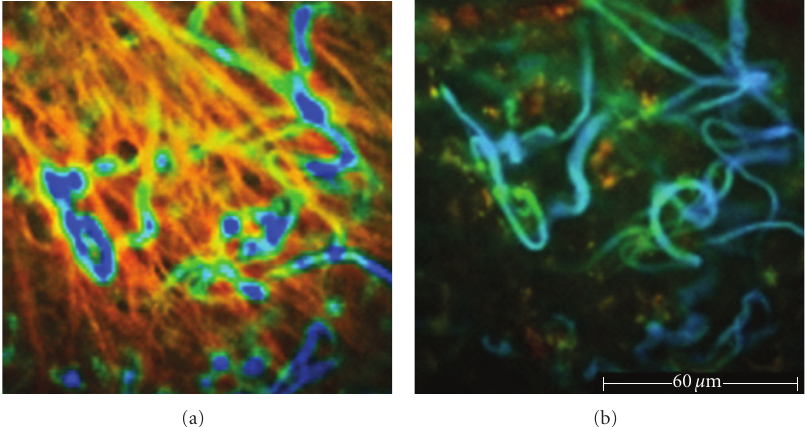
Figure 8: Dermis. (a) 100 μ m depth, 760 nm excitation wavelength. Thick and straight collagen fibers show low FLIM values (orange), whereas elastic fibers have high FLIM values and are represented in blue. (b) 100 μ m depths, 760 nm excitation wavelength (same spot). Employing the filter excluding SHG signals, curled blue elastic fibers are highlighted and their fine network is